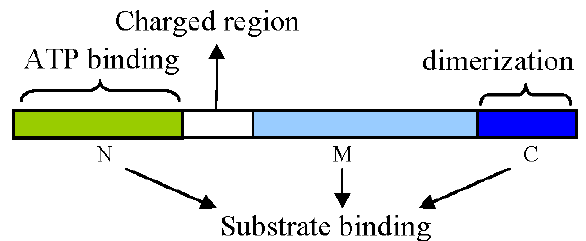
Figure 1. Structural model of Hsp90. Hsp90 consist of three domains: an N -terminal ATP-binding domain (N); a middle domain (M); and a C -terminal dimerization domain (C) with the pentapeptide MEEVD sequence. A charged region exists between the N and M domains. All three domains are reported to interact with different